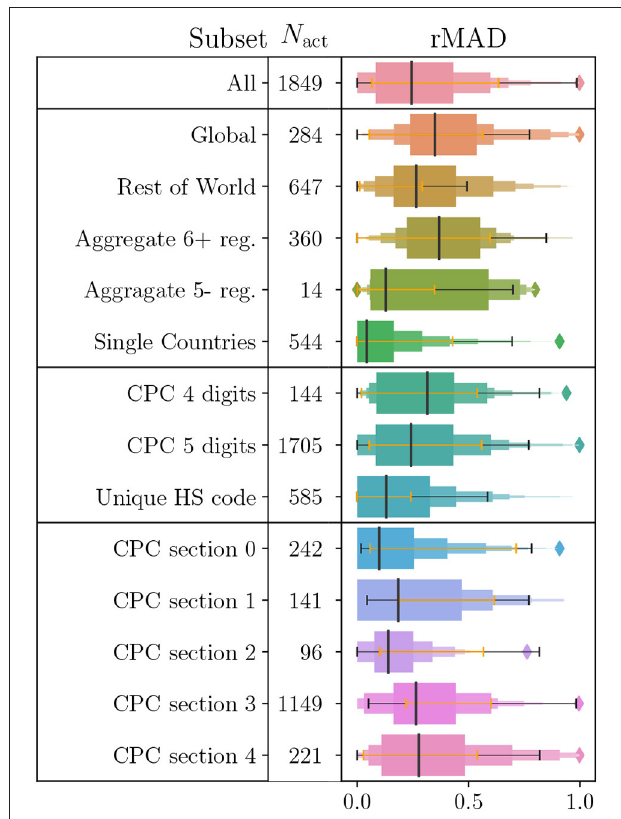
FIGURE 2 | The statistical price variance of the reference products of processes with a BACI price distribution, given as the median price variability of the robust indicator relative Median Absolute Deviation (rMAD) for different subsets of processes hybridised with BACI price data. The subsets are divided into three groups: “regional resolution,” “CPC-HS mapping quality,” and “commodity type.” The orange and black horizontal errorbars indicate the 16–84% and the 2.5–97.5% quantiles, respectively.